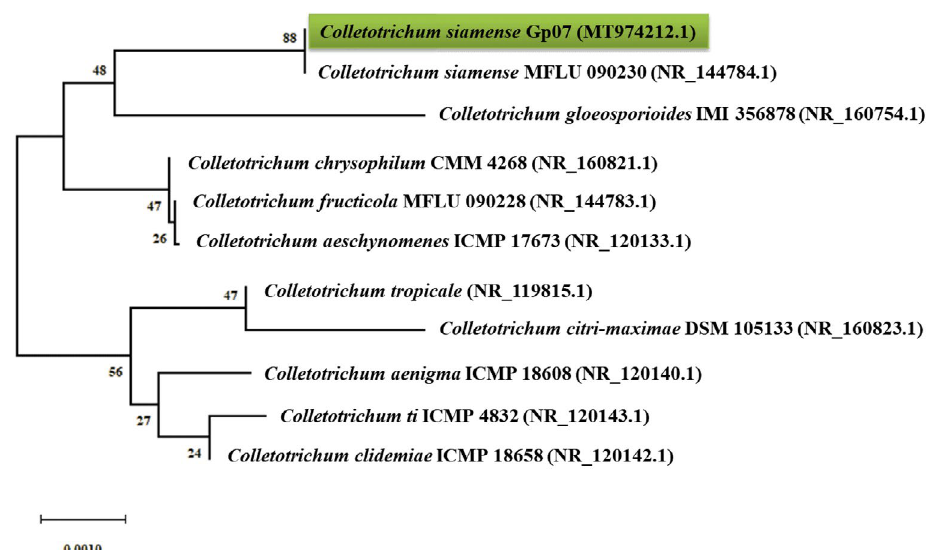
Fig. 3. Neighbor-joining (NJ) phylogram showing phylogenetic relationships between Colletotrichum siamense Gp07 and selected species of Colletotrichum based on ITS-rDNA sequences retrieved from GenBank. Phylogenetic tree was constructed based on the genetic distance using the Jukes-Cantor method with pairwise deletion of ambiguous positions and 1000×